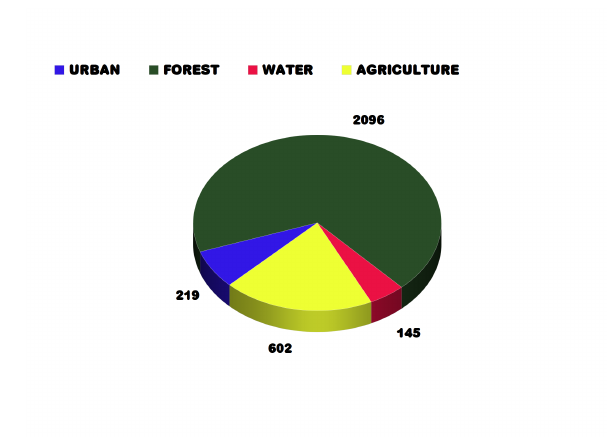
Figure 7: Collection of output Data generated by Sentinel-2 and LANDSAT-8 at resolution 30m by Gradient Tree Boost